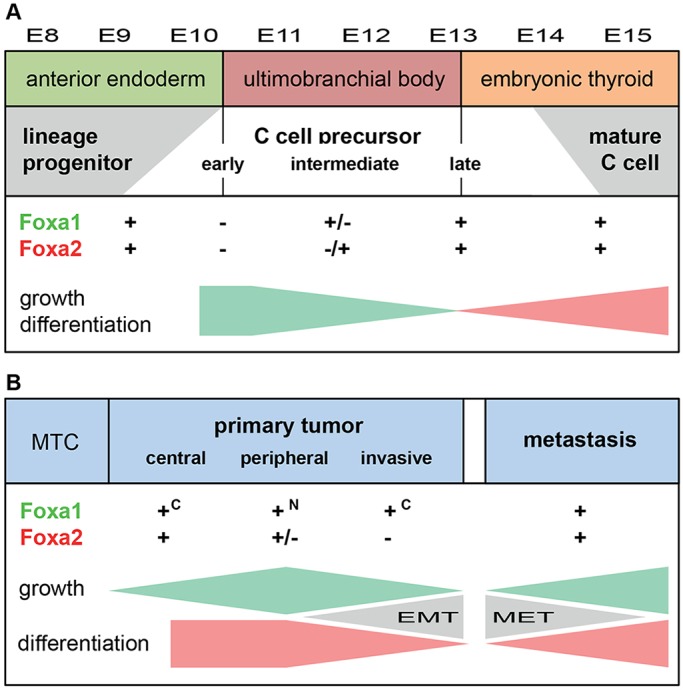
Lineage development of mouse thyroid C cells and mechanisms of tumor progression in human medullary thyroid cancer proposed from findings in the present study. Altered expression of Foxa1 and Foxa2 is correlated with growth (represented by green gradients) and differentiation (represented by pink gradients) in a spatiotemporally distinct pattern that shows both similarities and differences between embryonic C cell precursors (A) and neoplastic C cells (B). See Discussion for further comments. c, cytoplasmic localization; EMT, epithelial-to-mesenchymal transition; MET, mesenchymal epithelial transition; MTC, medullary thyroid carcinoma; N, nuclear localization.